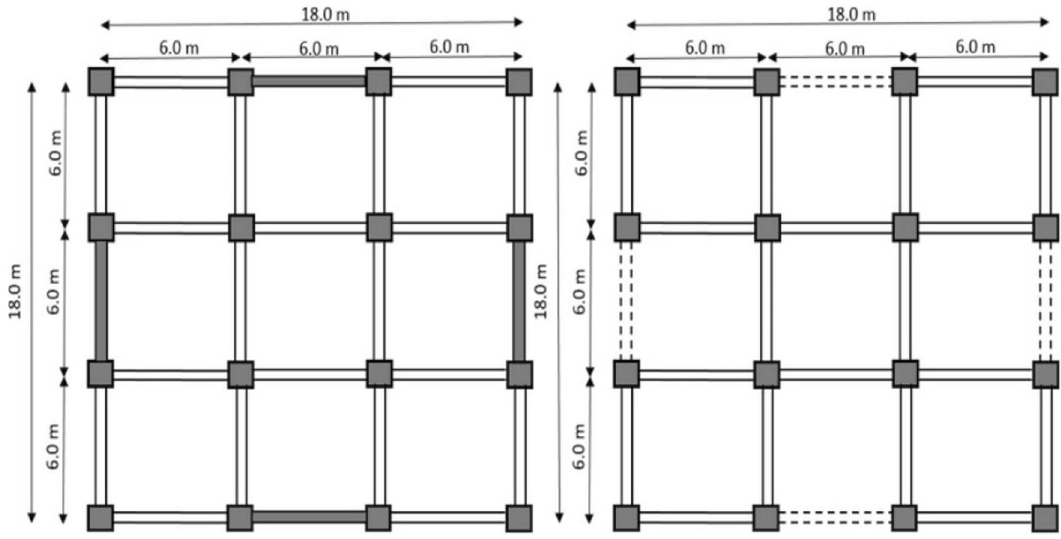
Fig. 2 Planar layout for the 10-story and 13-story reinforced concrete (RC) shear wall structures (left) and for the 7-story, 10-story, and 13-story concentrically braced steel structures (right) in Bucharest,